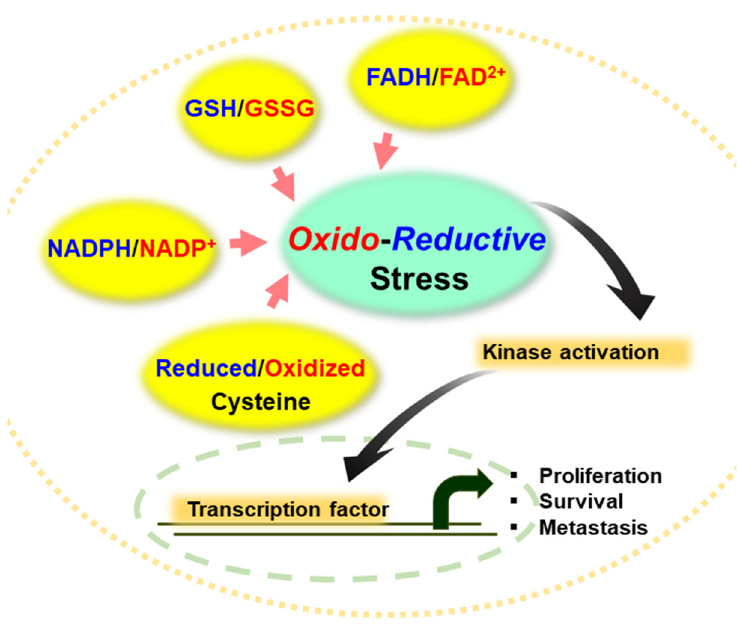
Figure 1. Representative antioxidant molecules and redox cofactors in regulating redox homeostasis. The ratio of GSH/GSSG, NADPH/NADP + and FADH 2 /FAD 2+ as well as the status of cysteine residues in proteins determines oxidative or reductive stress in normal and cancer cells, thereby modulating activity of kinases and transcription of genes involved in cell proliferation, survival, and metastasis.